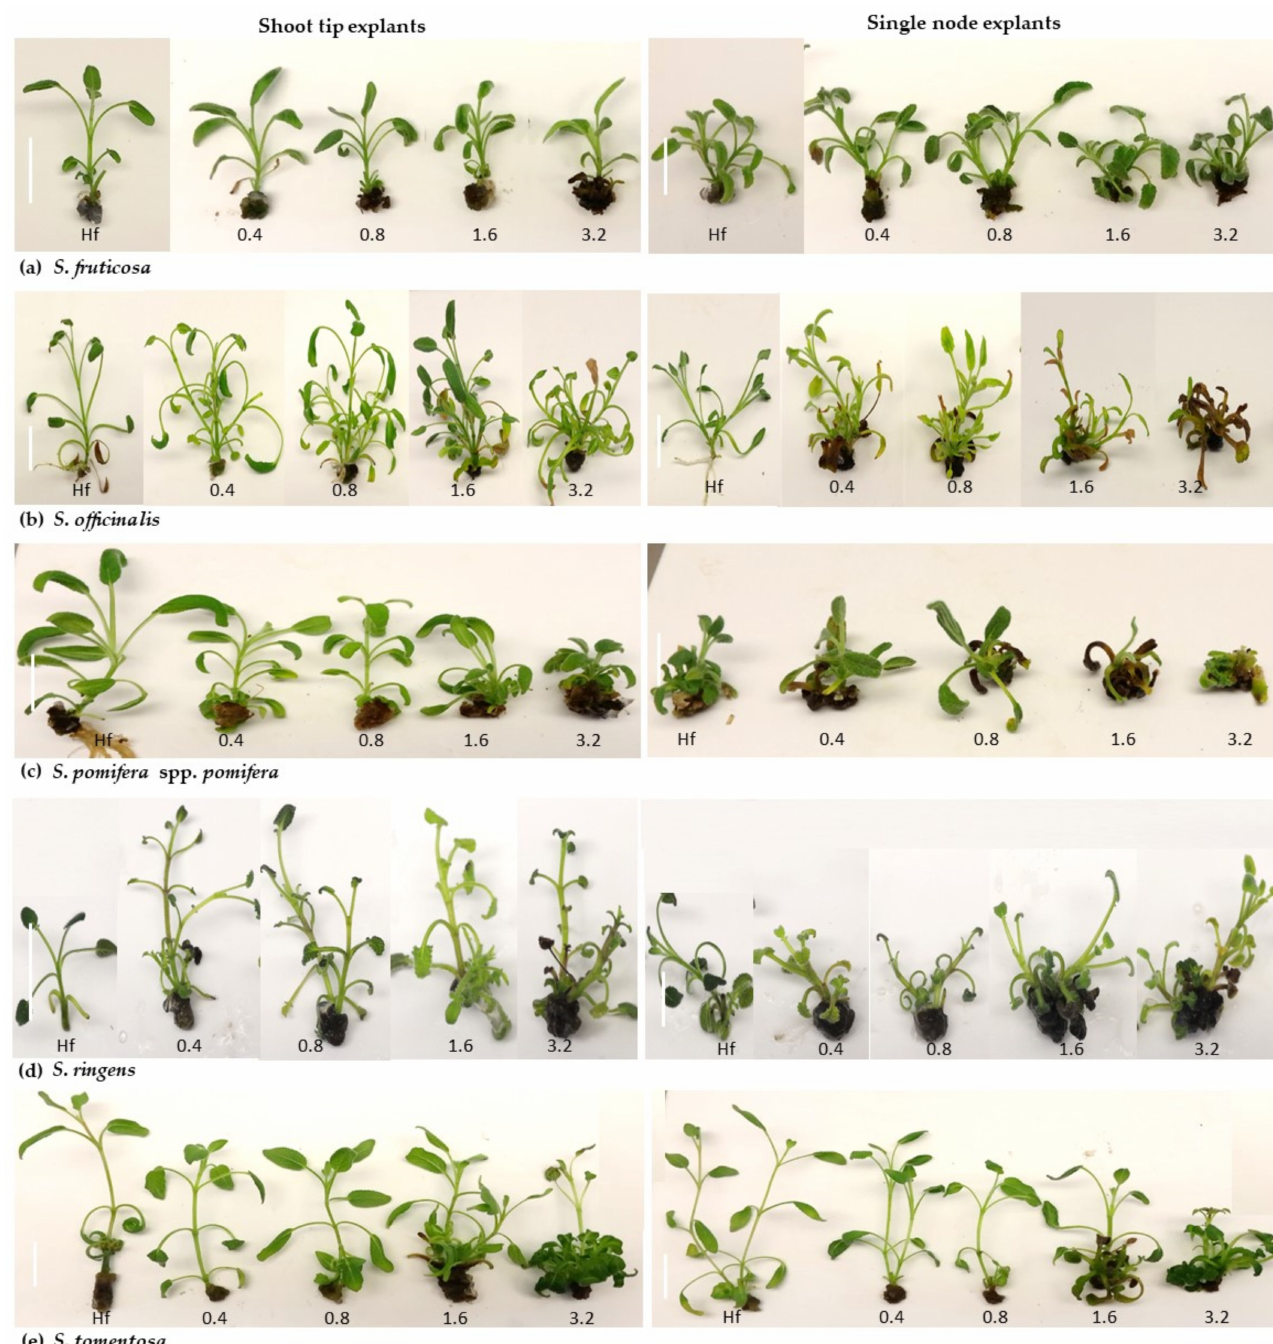
Figure 6. Characteristic response of shoot tip and single node explants of Salvia fruticosa ( a ), S. officinalis ( b ), S. pomifera spp. pomifera ( c ), S. ringens ( d ) and S. tomentosa ( e ) during the multi- plication stage, when cultured on MS medium either hormone free (Hf) or supplemented with 0.01 mg L − 1 NAA and BA concentration (mg L − 1 ) marked. Size bar s = 1.0 cm. Shoot length and number of nodes per shoot were the highest in Hf medium, while all media with BA reduced to a similar extent the shoot length and number of nodes in the generated shoots, to half of that of Hf medium (Figure